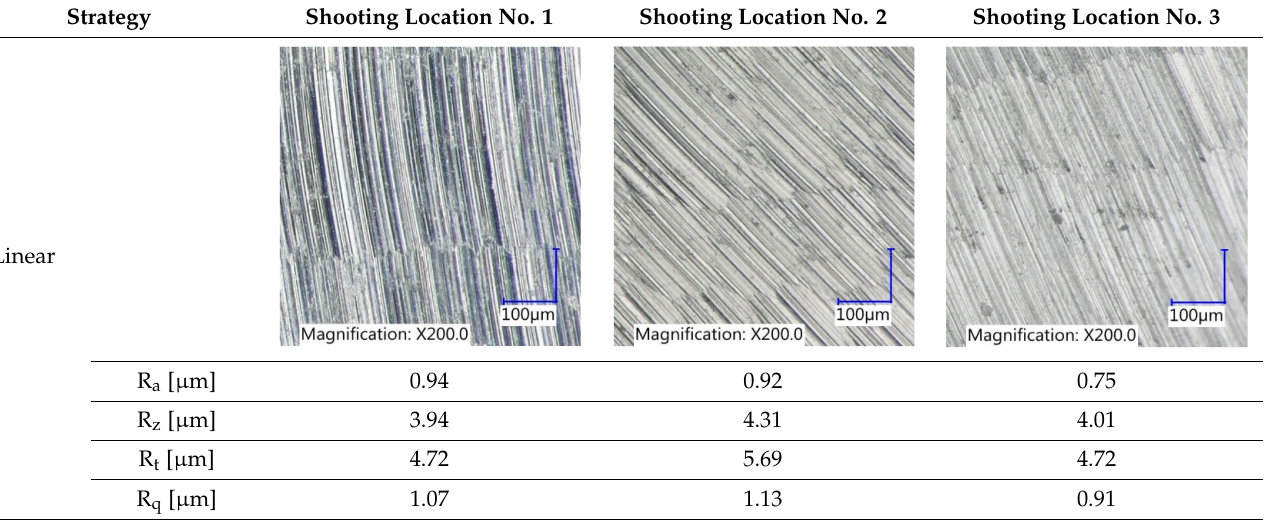
Table 6. Surface texture and surface roughness in 5-axis